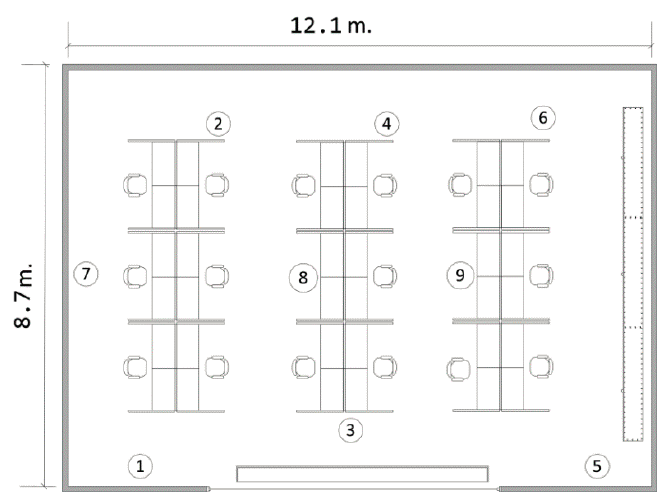
Figure 4. The testing area.